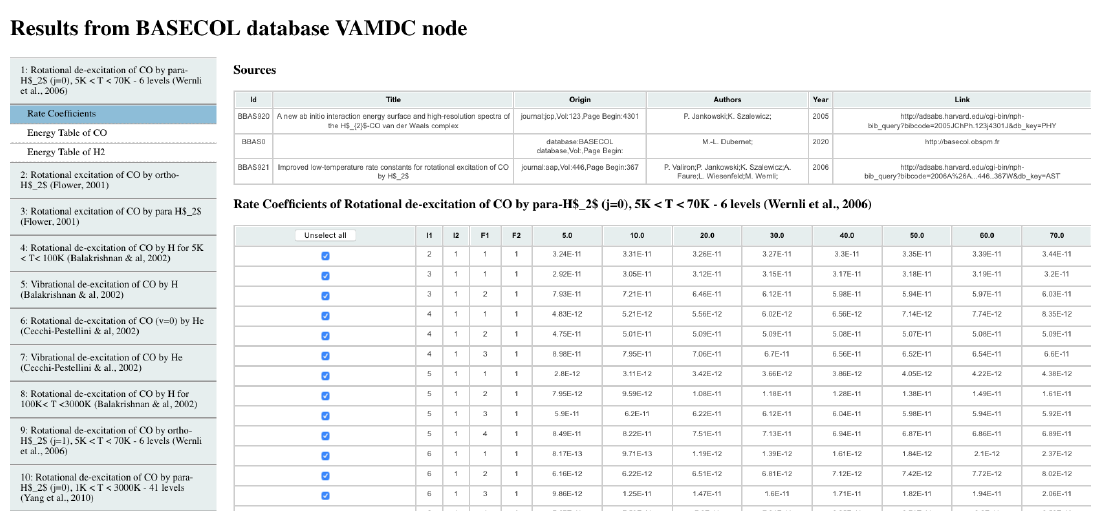
Figure 8. VAMDC portal display of BASECOL